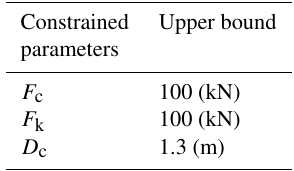
Table 3. Range of constrained parameters.